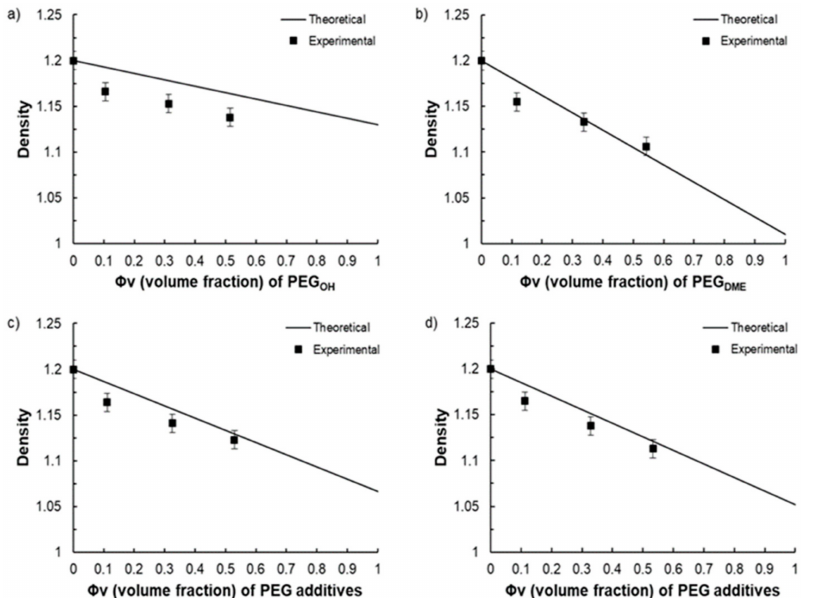
Figure 7. Comparison between the experimental film density measured by helium pycnometry and the theoretical film density calculated by an additive law as a function of the volume fraction of the additive(s) for Pebax ® /PEG OH blends ( a ), Pebax ® /PEG DME blends ( b ), Pebax ® /PEG OH /PEG DME with a 50/50 PEG OH /PEG DME weight ratio ( c ), and Pebax ® /PEG OH /PEG DME with a 37.5/62.5 PEG OH /PEG DME weight ratio ( d